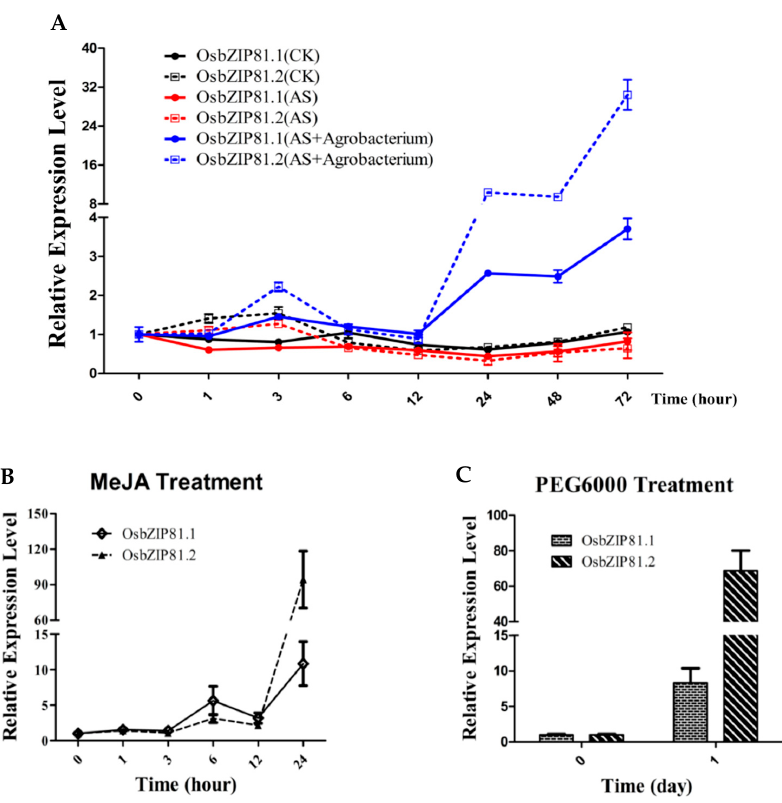
Figure 8. Expression of OsbZIP81 under different biotic and abiotic stresses. ( A ) Agrobacterium tumefaciens infection of rice callus (Zhonghua 11, ZH11) with EHA105 strain and AS (100 μ mol/L) treatment. Samples were collected after 0, 1, 3, 6, 12, 24, 48, and 72 h. ( B ) Methyl Jasmonic Acid (MeJA) (200 μ mol/L) treatment. Samples were collected after 0, 1, 3, 6, 12, 24, 48, and 72 h. ( C ) PEG6000 (20%) treatment. Samples were harvested one day after treatment. The values in each column are the means of three independent replicates and error bars represent the SEM.